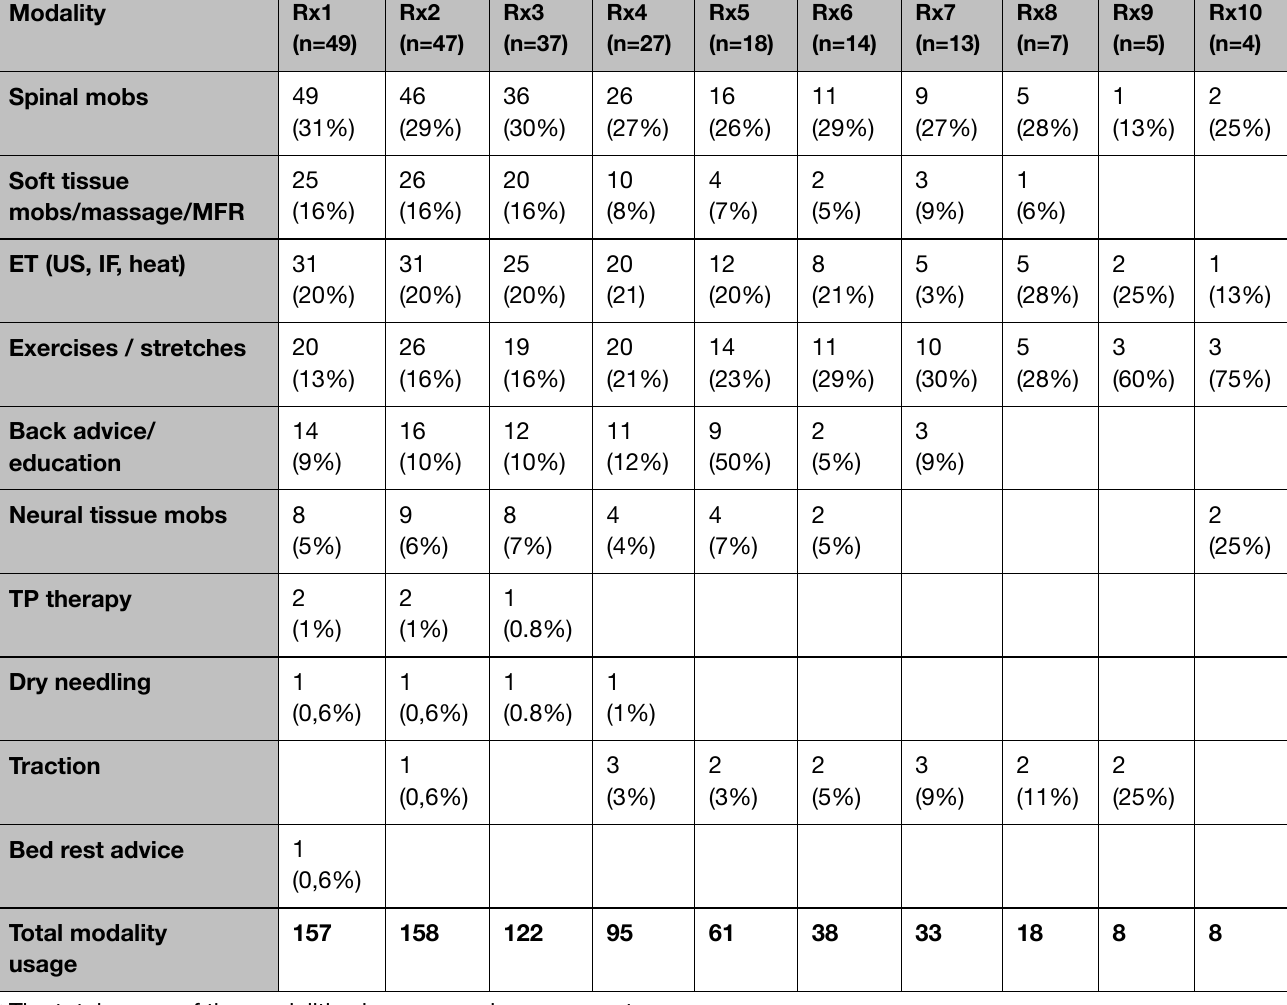
Table 7: Frequency of use of each Physiotherapy modalities per treatment and % overall use for entire cohort (visit 1 to 10)